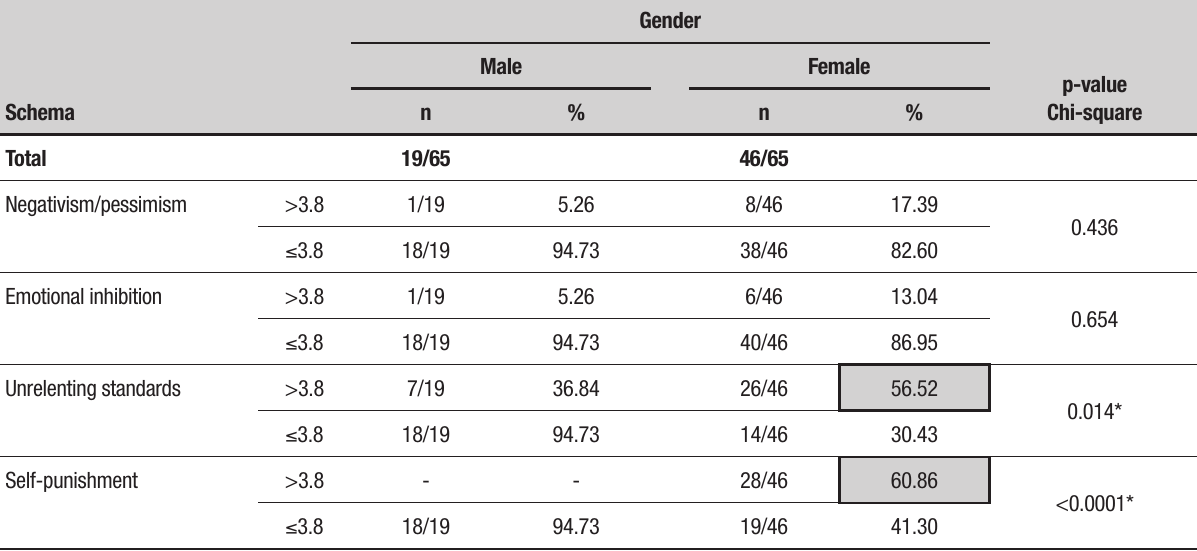
Table 2. Evaluation of early maladaptive schemas related to hypervigilance and inhibition according to gender.